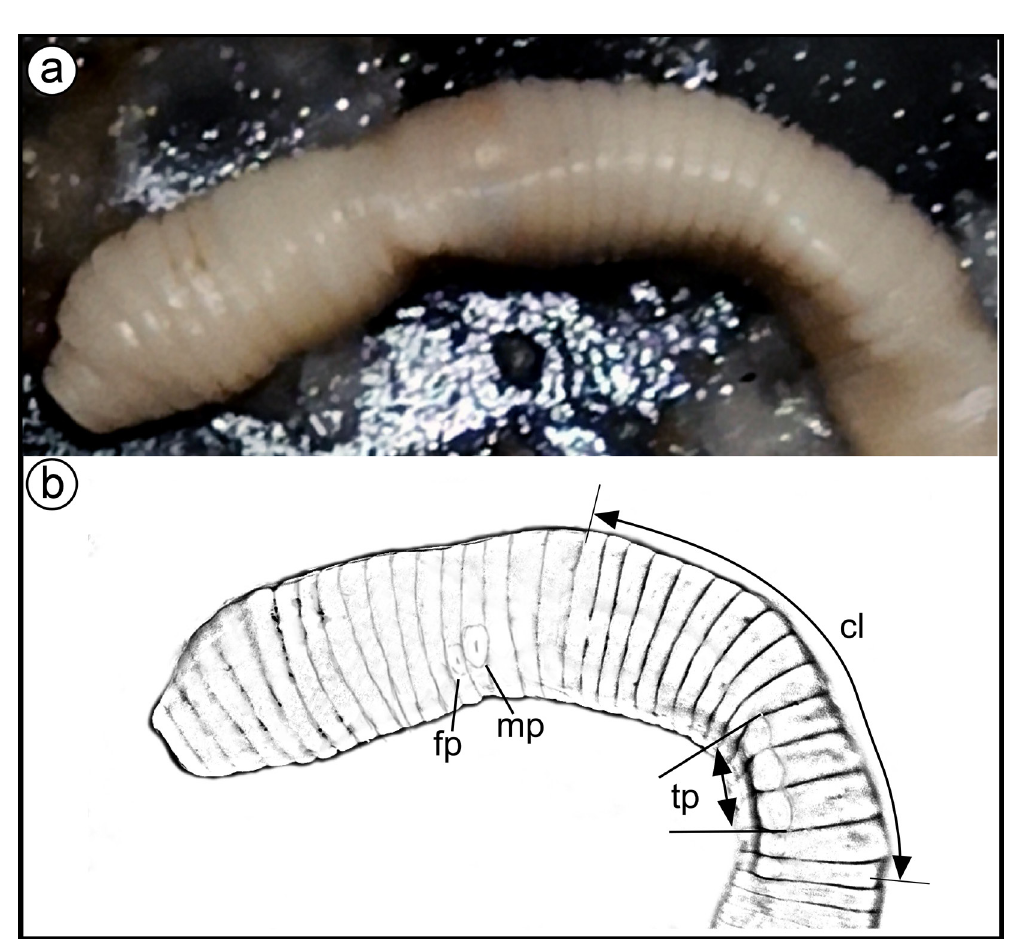
specimen. b . Schematic drawing. Abbreviations: cl = clitellum; fp = female pore; mp = male pore; tp = tubercula